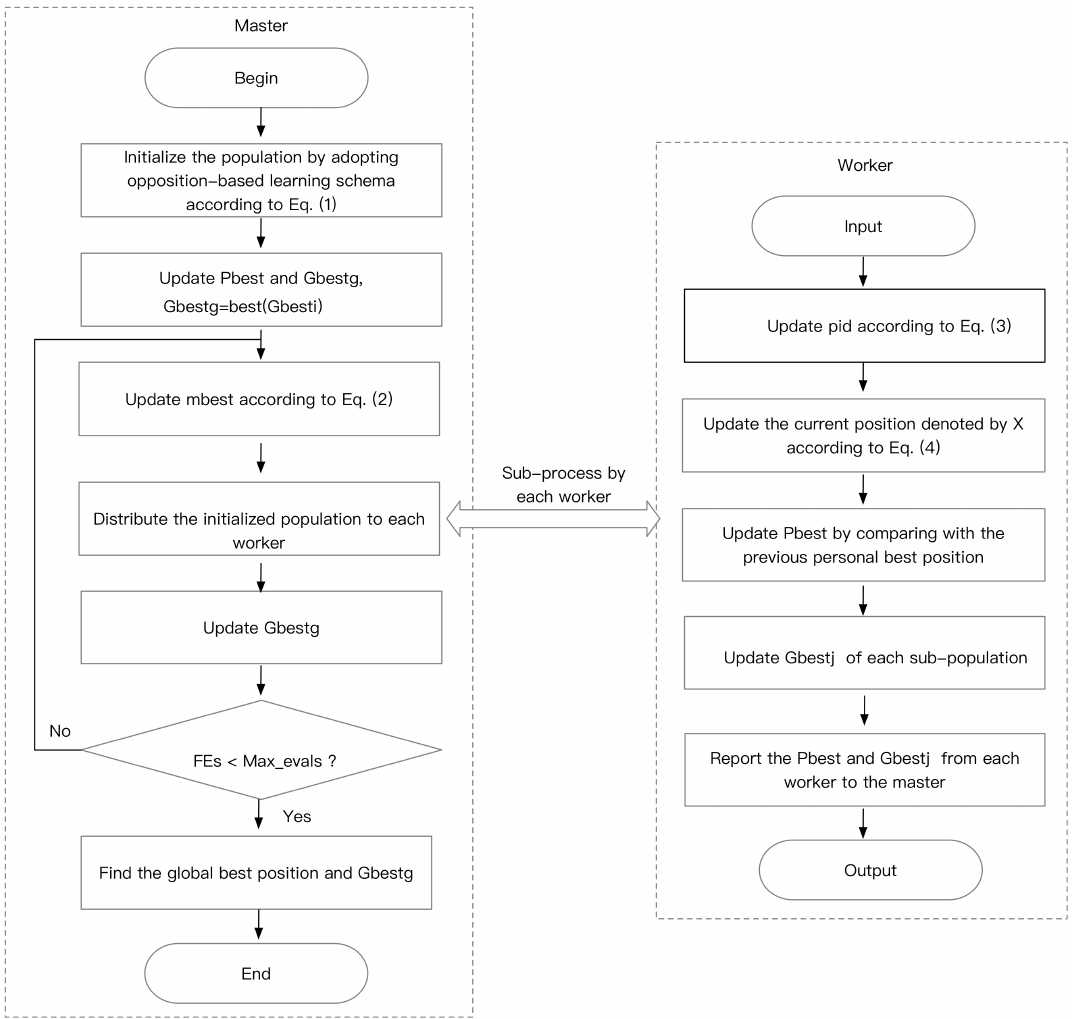
Figure 4. The evolution process of the distributed quantum-behaved particle swarm optimization (SDQPSO)